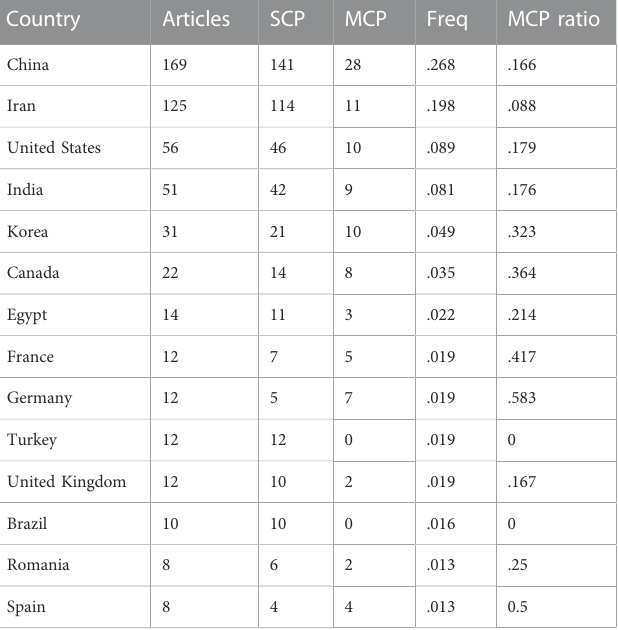
TABLE1Top10countries withthehighestproductivityofpublicationsrelated to applications of NHs for drug delivery (based on the countries of the corresponding